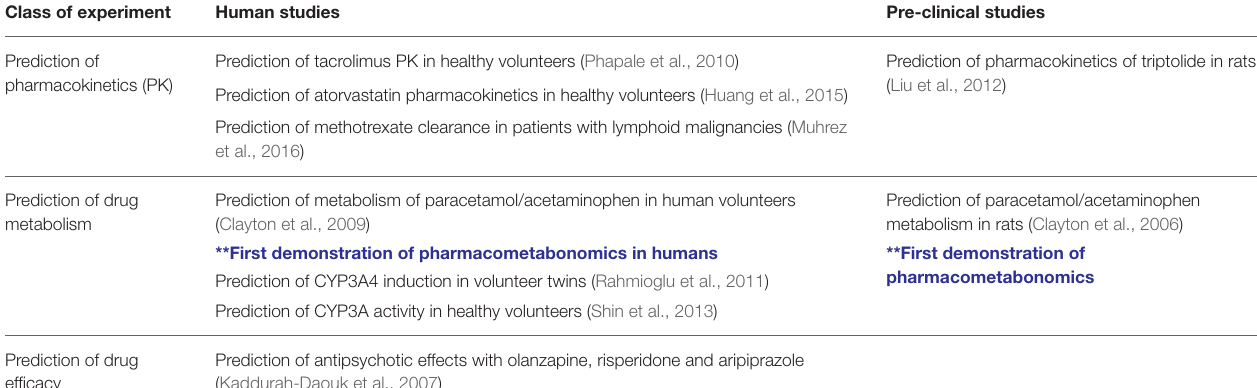
TABLE 1 | The use of pharmacometabonomics to predict drug efficacy, toxicity, metabolism, and pharmacokinetics a . Class of experiment